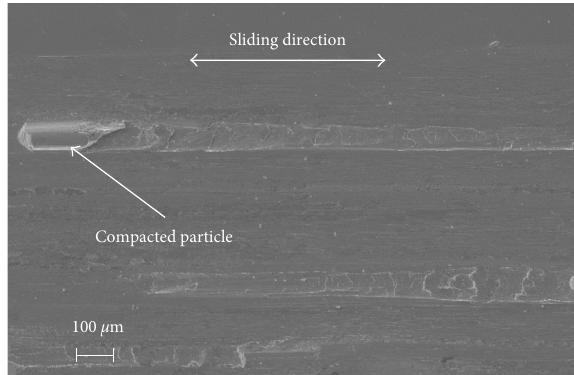
Figure 15: Scanning electron microscope micrograph of the steel 1 disk surface tested at 200 ° C.